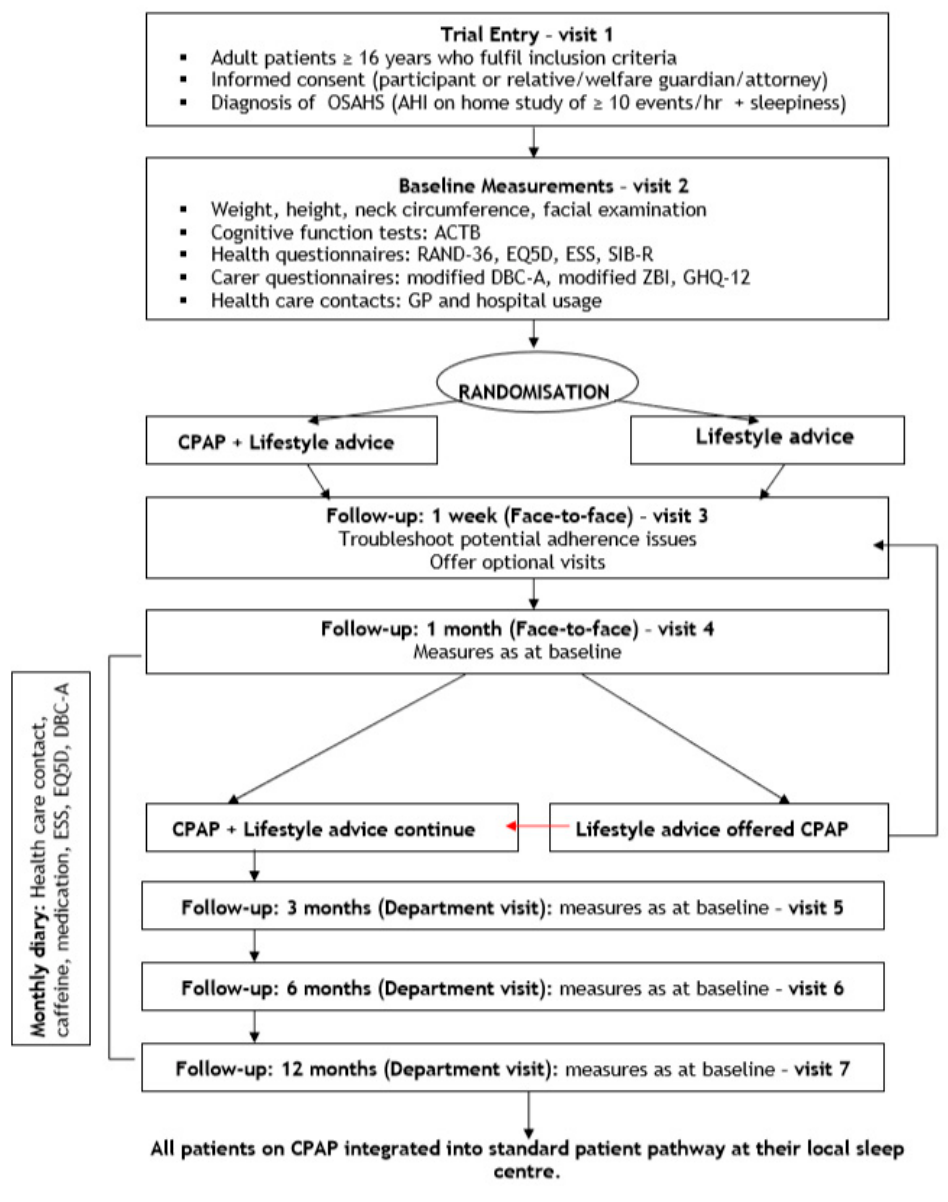
Figure 1. Flow diagram of CPAP evaluation phase of study: trial entry, randomisation, treatment arms, and follow-up schedule.